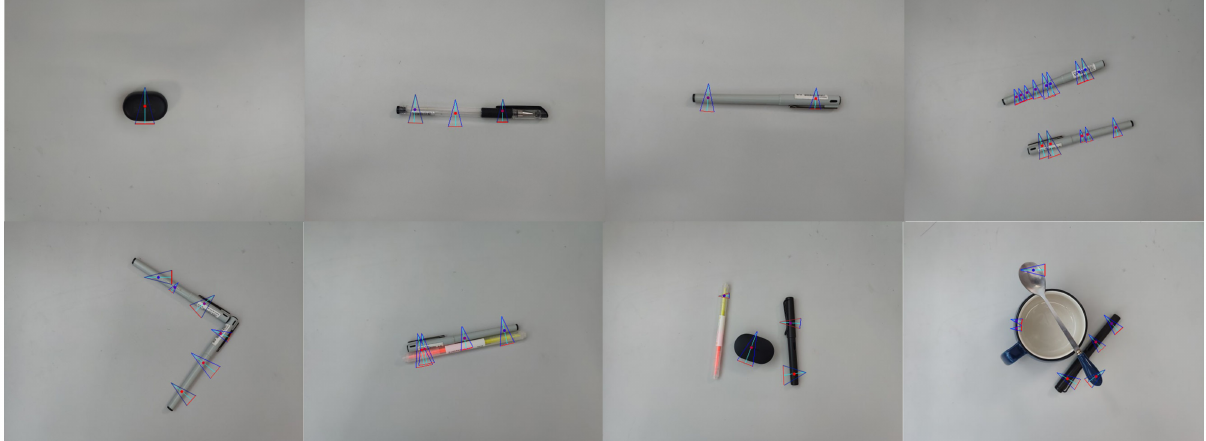
Figure 8. The above eight images are visualizations of detection in more realistic and complex